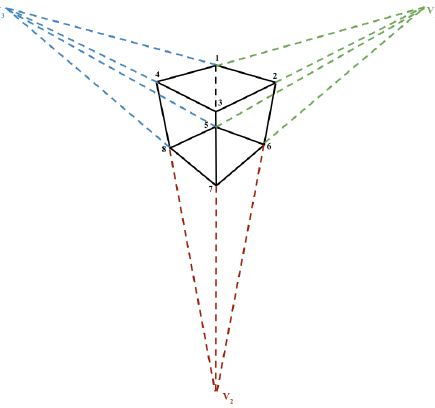
Figure 3. Vanishing point representation for a cube.